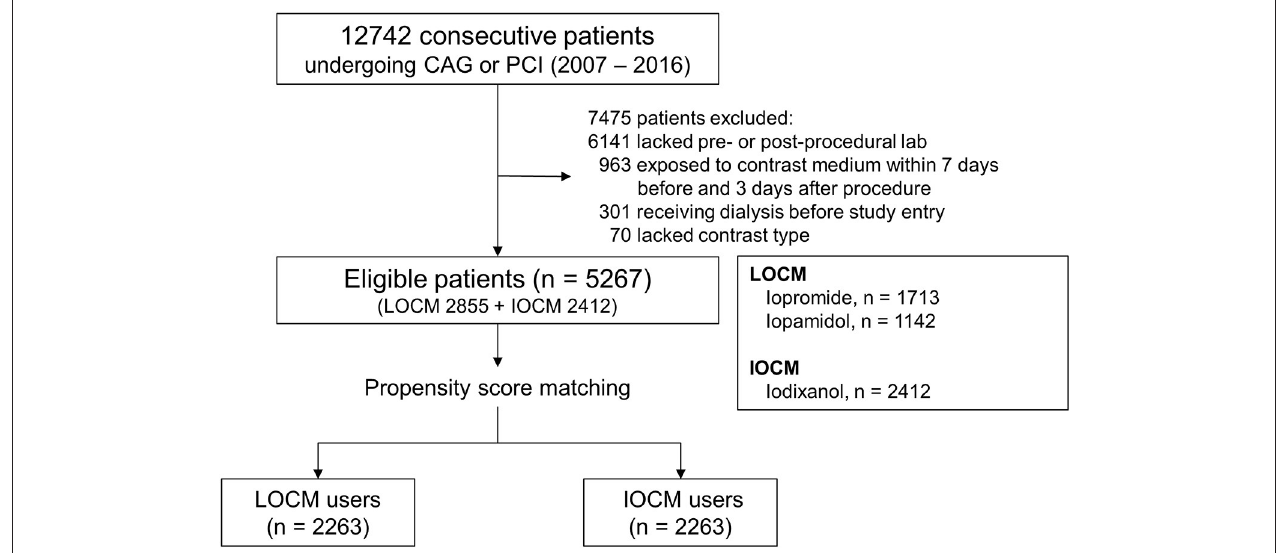
FIGURE 1 | Cohort formation. CAG, coronary angiography; PCI, percutaneous coronary intervention; LOCM, low-osmolar contrast media; IOCM, iso-osmolar contrast media. status; CHF; baseline levels of eGFR, hemoglobin,